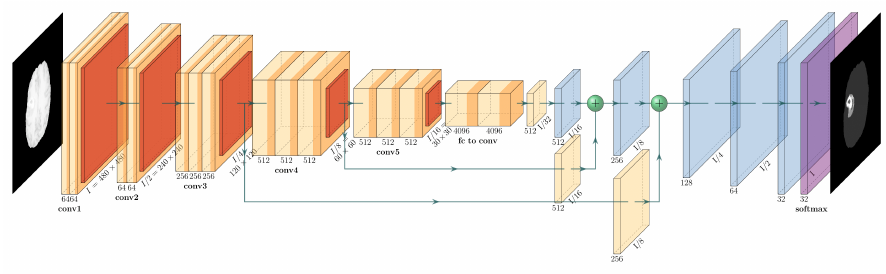
Figure 1. VGG-FCN Architecture: 15 convolution layers; 5 pooling layers; 5 deconvolution layers (their input is the sum of previous layer and the output of the corresponding convolution layer).